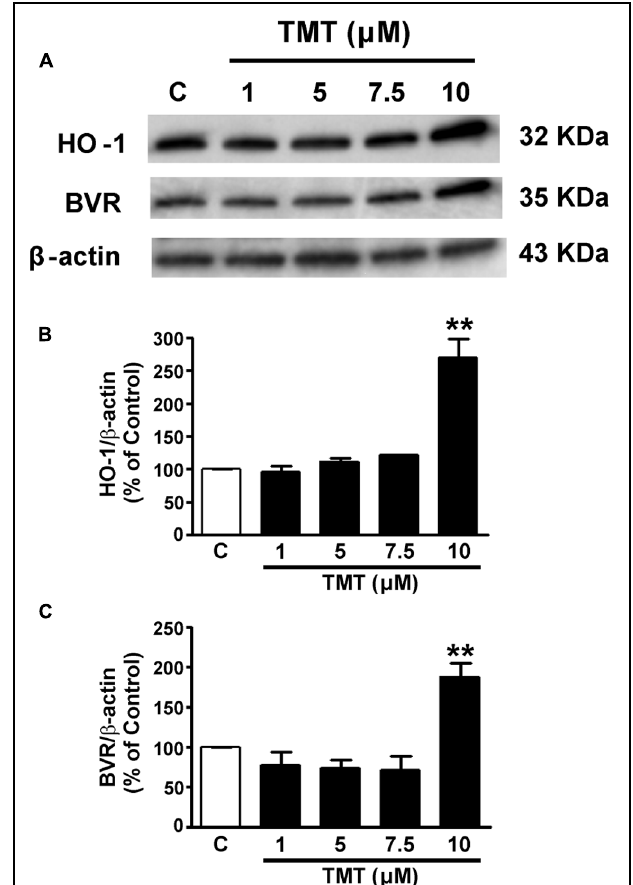
FIGURE 1 | Trimethyltin (TMT) increases both heme oxygenase-1 (HO-1) and biliverdin reductase (BVR) expression in SH-SY5Y cells. SH-SY5Y cells were treated with TMT (1–10 μ M) for 24 h and Western Blot was performed as described in the section “Materials and Methods.” (A) shows representative gels regarding HO-1 and BVR protein expression. Bar graphs represent the quantification of HO-1 (B) and BVR (C) protein levels normalized for β -actin expression. Data are expressed as a mean ± SEM of 4–7 replicates per group. ∗∗ P < 0.01 vs. controls. C,